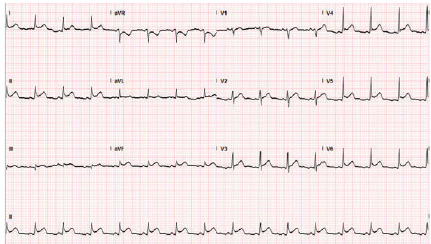
Figure 5: EKG 24hrs after admission. Diffuse ST segment elevation and slight PR segment